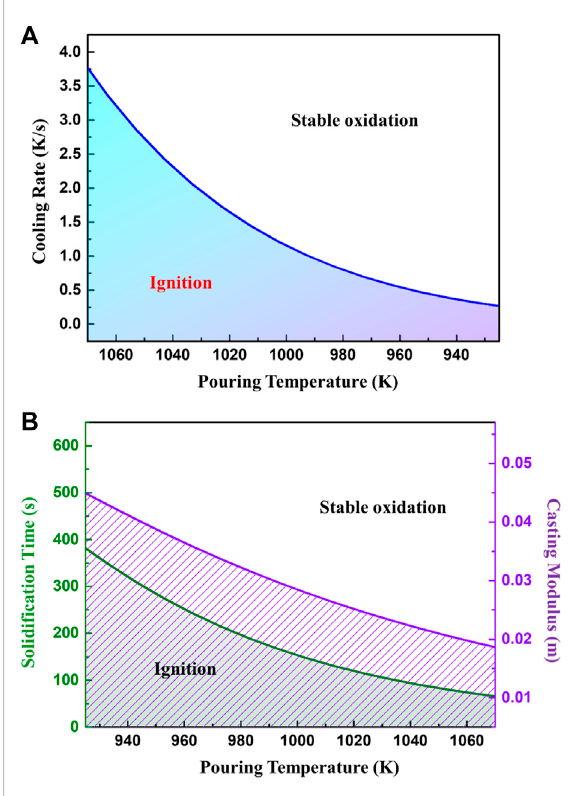
FIGURE 14 The ignition criteria for casting cooling processes. (A)